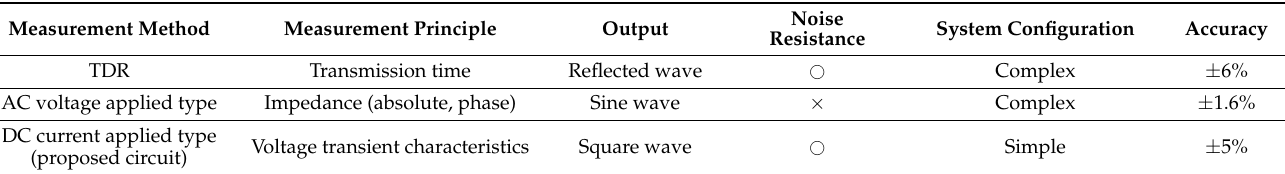
Table 1. Comparison with the other